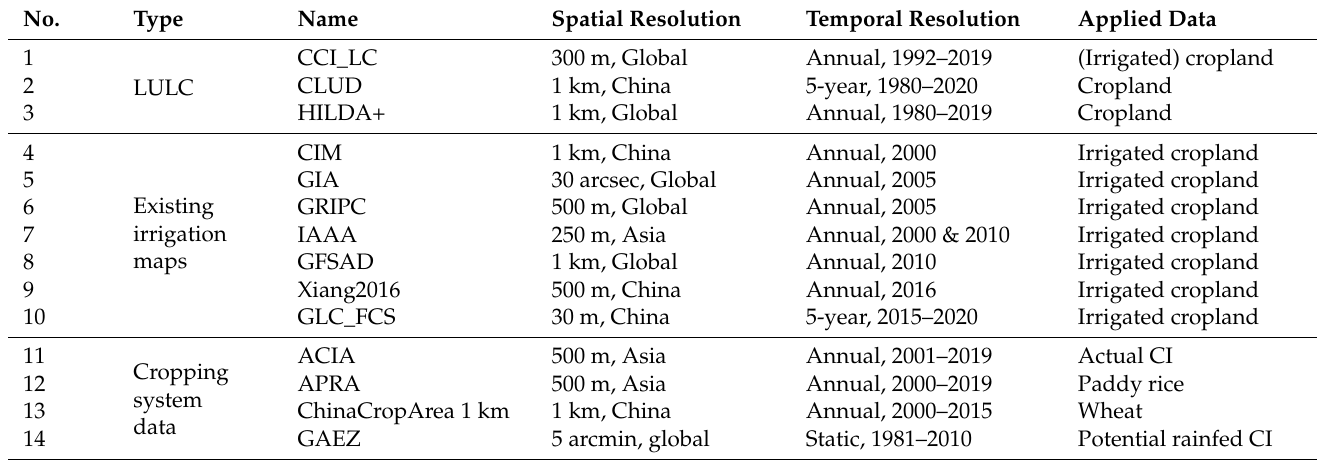
Table 1. Applied satellite-based